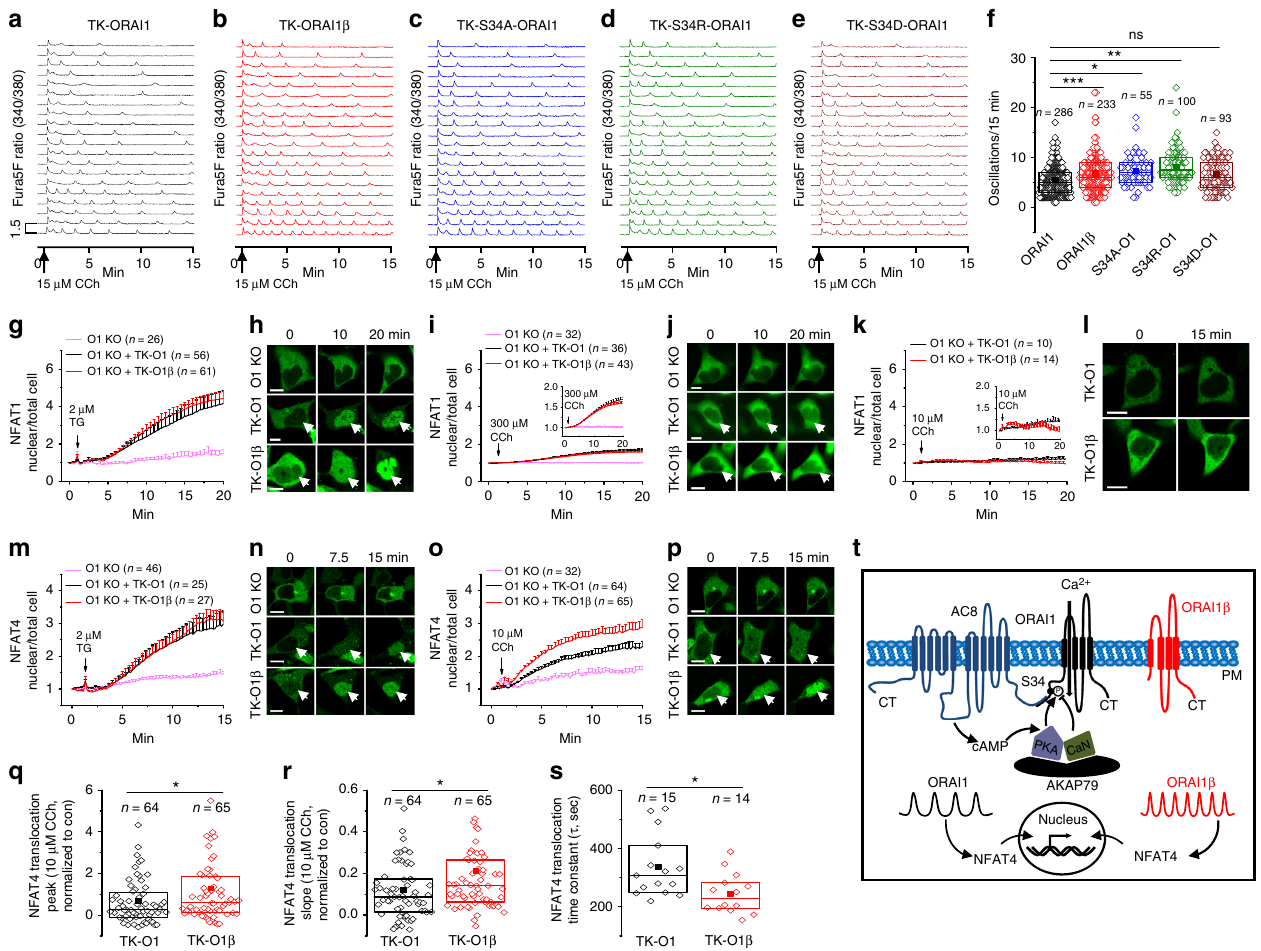
Fig. 5 CDI regulates the frequency of ORAI1 Ca 2 + oscillations and NFAT activation. a – f Representative traces depicting cytosolic Ca 2 + oscillations activated by 15 µ M carbachol (Cch) and measured with the dye Fura5F in ORAI1-KO cells expressing different ORAI1 cDNA plasmids driven by the weak TK promoter (without STIM1 co-expression). These are: a ORAI1-CFP, b ORAI1 β -CFP, c S34A ORAI1-CFP, d S34R ORAI1-CFP, and e S34D ORAI1-CFP. f Summary data of number of Ca 2 + oscillations/15 min represented as boxplots showing the mean and median, with box representing the 25th to 75th percentile range. g – p Representative fl uorescence traces and corresponding images of g – l NFAT1-GFP and m – p NFAT4-GFP nuclear/total ratio changes over time in response to thapsigargin (TG) and different concentrations of carbachol (Cch) in ORAI1-KO cells expressing either ORAI1-CFP (black traces), or ORAI1 β -CFP (red traces) driven by the weak TK promoter. ORAI1-KO cells transfected only with NFAT-GFP (pink traces) are shown. Data represented as mean ± SEM. White arrows in picture points to NFAT-GFP nuclear translocation. Scale bar: 10 µ m. Insets in ( i ) and ( k ) represent the same data on a different y scale. q Peak, r slope, and s time constant of NFAT4-GFP nuclear translocation in response to 10 µ M carbachol in ORAI1-KO cells expressing either ORAI1-CFP, or ORAI1 β -CFP. s Time constants could be reliably calculated only from a portion of cells. Data are represented as boxplots showing the 25th to 75th percentile range, mean and median of the peak, slope and time constant. t Cartoon summarizing fi ndings from the current study. * p < 0.05, ** p < 0.01, *** p < 0.001, two-tailed Student ’ s t test was used for ( f , q , r , s